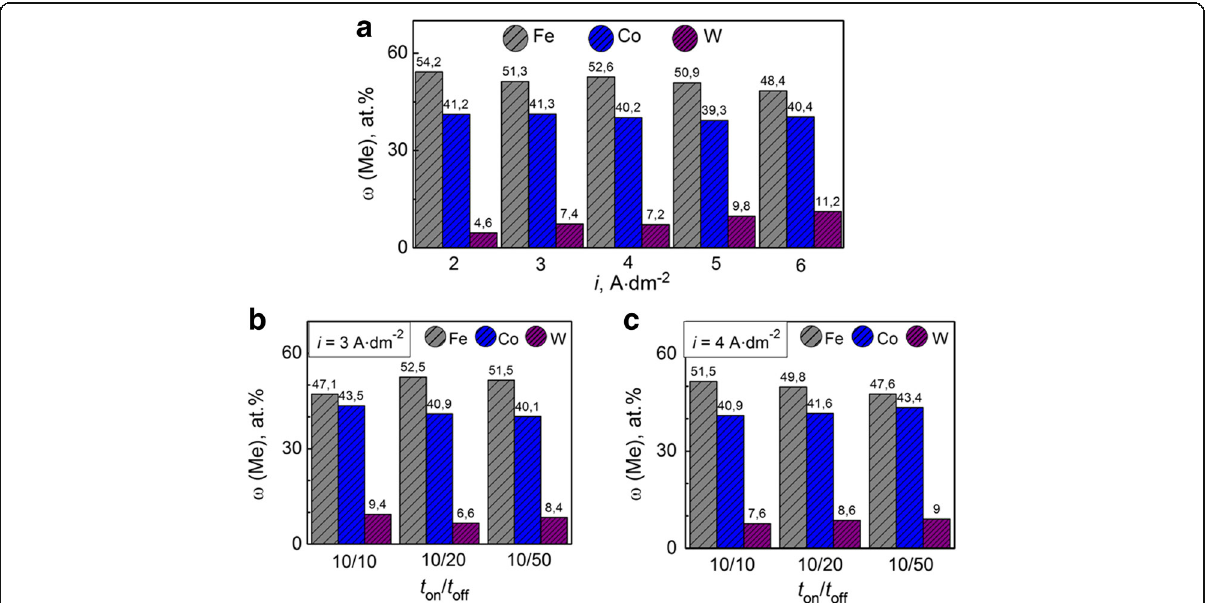
Fig. 2 Current density influence on the composition of Fe-Co-W alloys with thickness of 10 μ m deposited onto copper substrate. a Galvanostatic electrolysis. b , c Pulse mode